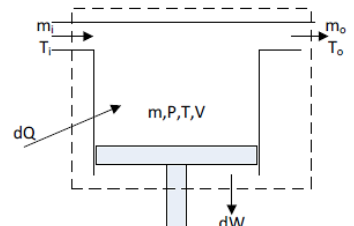
Fig. 3 Cylinder control